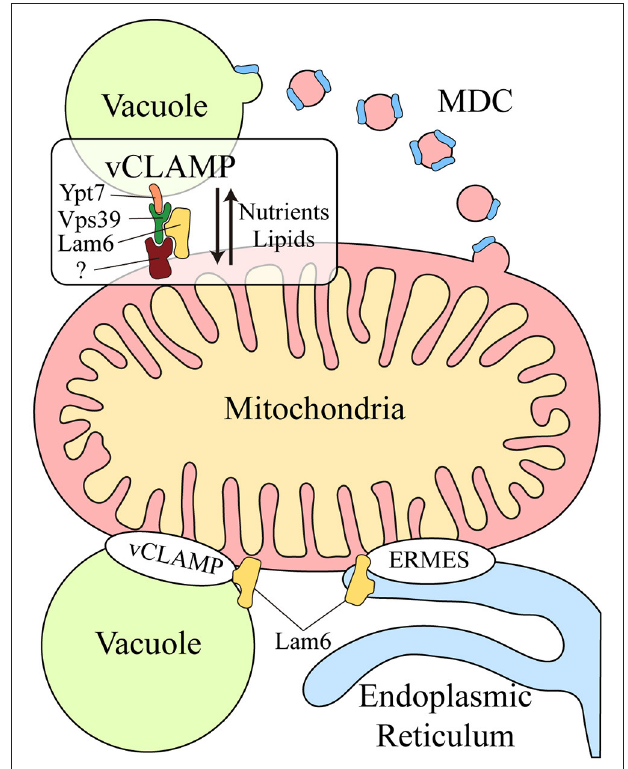
FIGURE 1 | Crosstalk between the mitochondria and lysosomal vacuole in yeast. Two different mechanisms exist for molecular exchange between the mitochondria and lysosomal vacuole: vesicular transport and physical contacts. Mitochondrial membrane proteins can be transported from the mitochondria to the vacuole through the formation of the mitochondrial derived compartment (MDC), particularly for their degradation by autophagy. This mechanism is a protective pathway to preserve mitochondrial integrity in times of stress. In addition, mitochondria and the lysosomal vacuole establish physical contacts, the vacuole and mitochondria patch (vCLAMP), which involves the Vps39, Ypt7, and Lam6 proteins and an unidentified mitochondrial component. This connection participates in the exchange of nutrients and lipids between these organelles. Lam6 is also present in endoplasmic reticulum-mitochondria encounter structure (ERMES), the physical contact between mitochondria and the endoplasmic reticulum. The presence of Lam6 in both mitochondrial contacts makes their co-regulation possible. Hence, vCLAMP is more extensively distributed in an ERMES mutant and conversely, there are more ERMES when vCLAMP is impaired. MDC, Mitochondrial derived compartment; vCLAMP, vacuole and mitochondria patch;